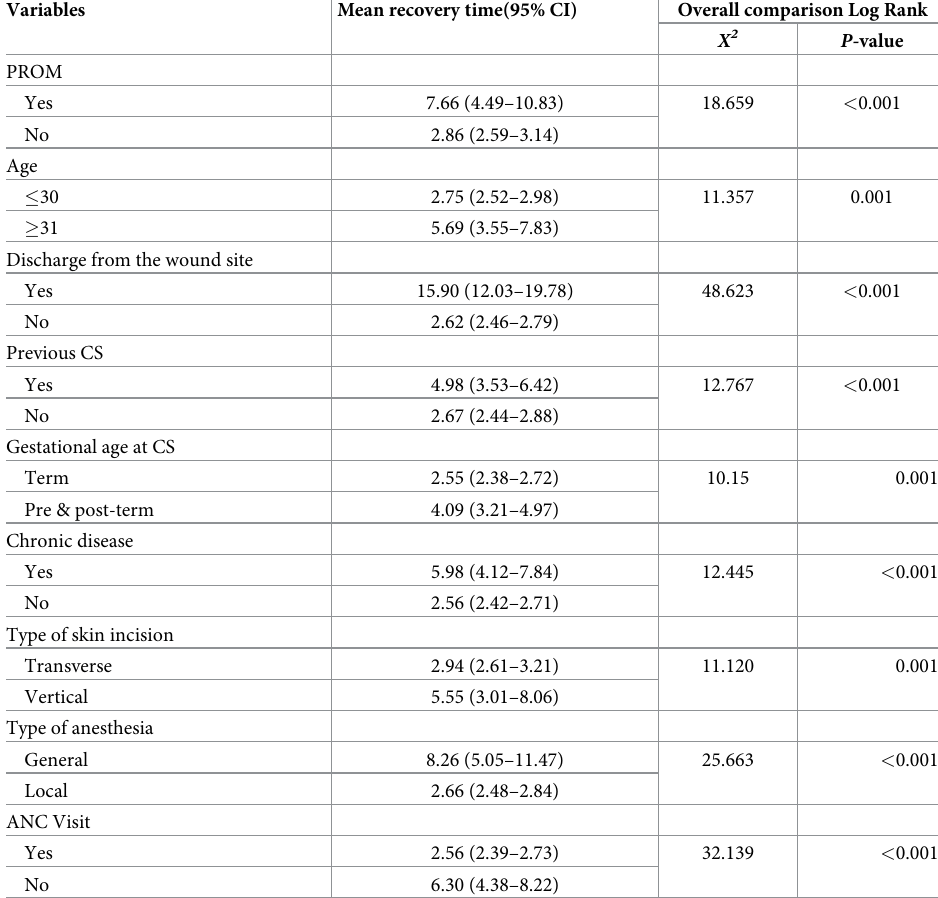
Table 6. Log rank (Mantel-Cox) test for association of explanatory variables with time-to-recovery after CS deliv- ery among women who gave birth by CS delivery at HUCSH,